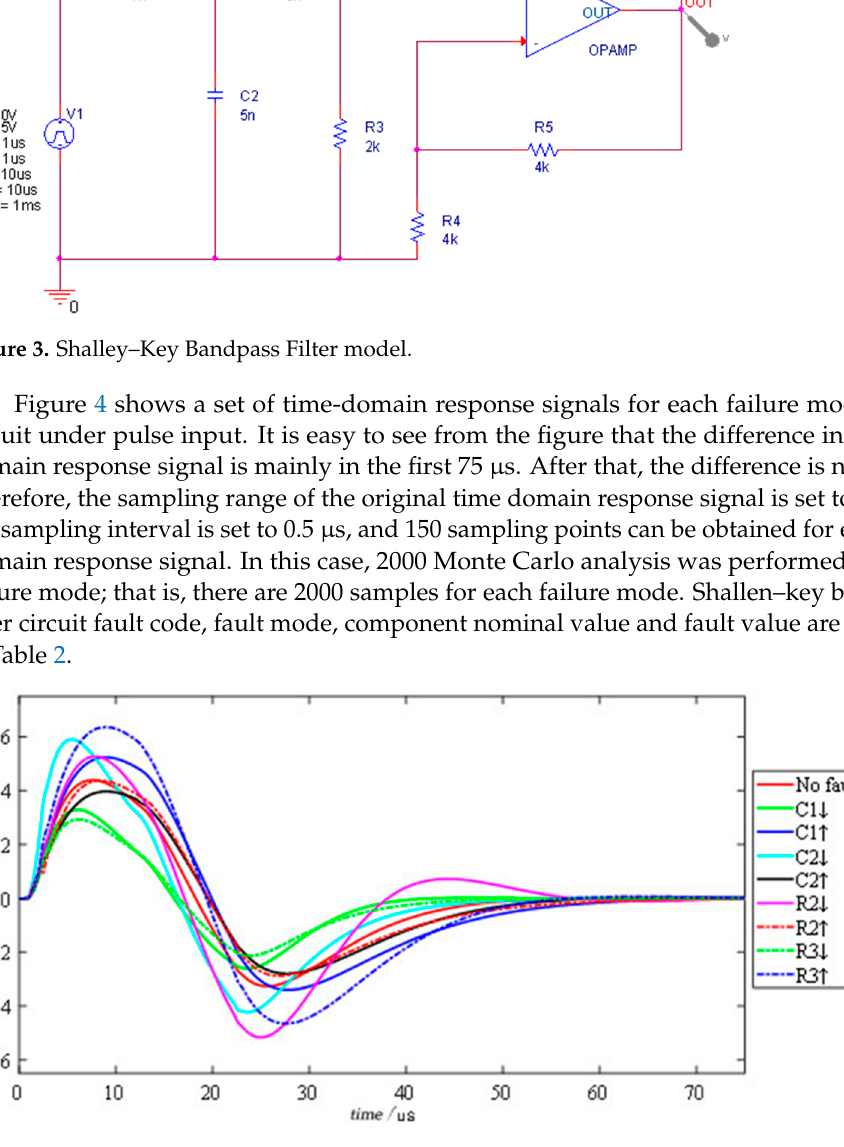
Figure 4. Output signals of different fault patterns in the Salley–Key Bandpass Filter.